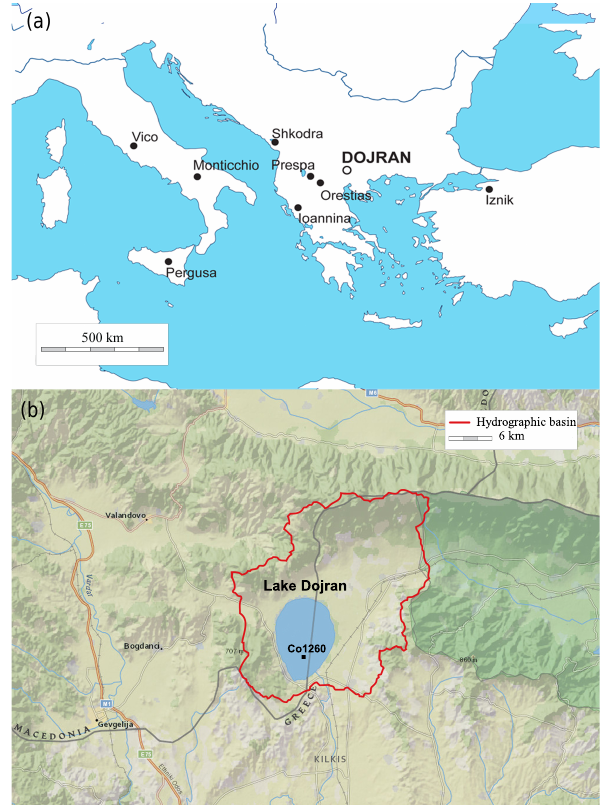
Figure 1. (a) Location of Lake Dojran and the other sites mentioned in the paper. (b) Detail of the lake and its surrounding, the hydrolog- ical basin and the location of the analyzed core Co1260. The map is taken from Basemap Esri (https://www.esri.com/en-us/home, last access: 8 March